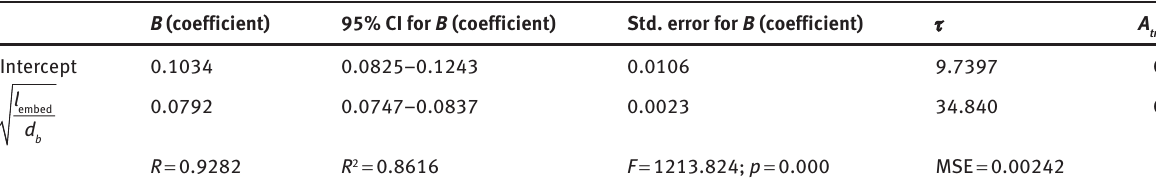
Table 3: Regression analysis results.